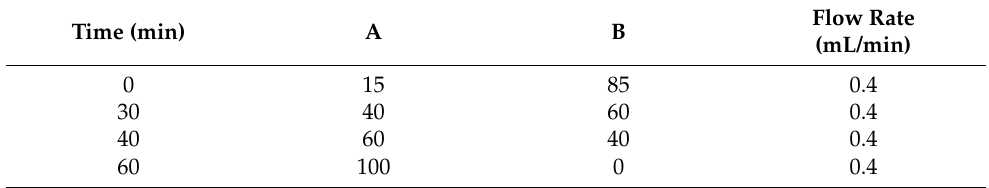
Table 1. Mobile phase condition of chromatographic